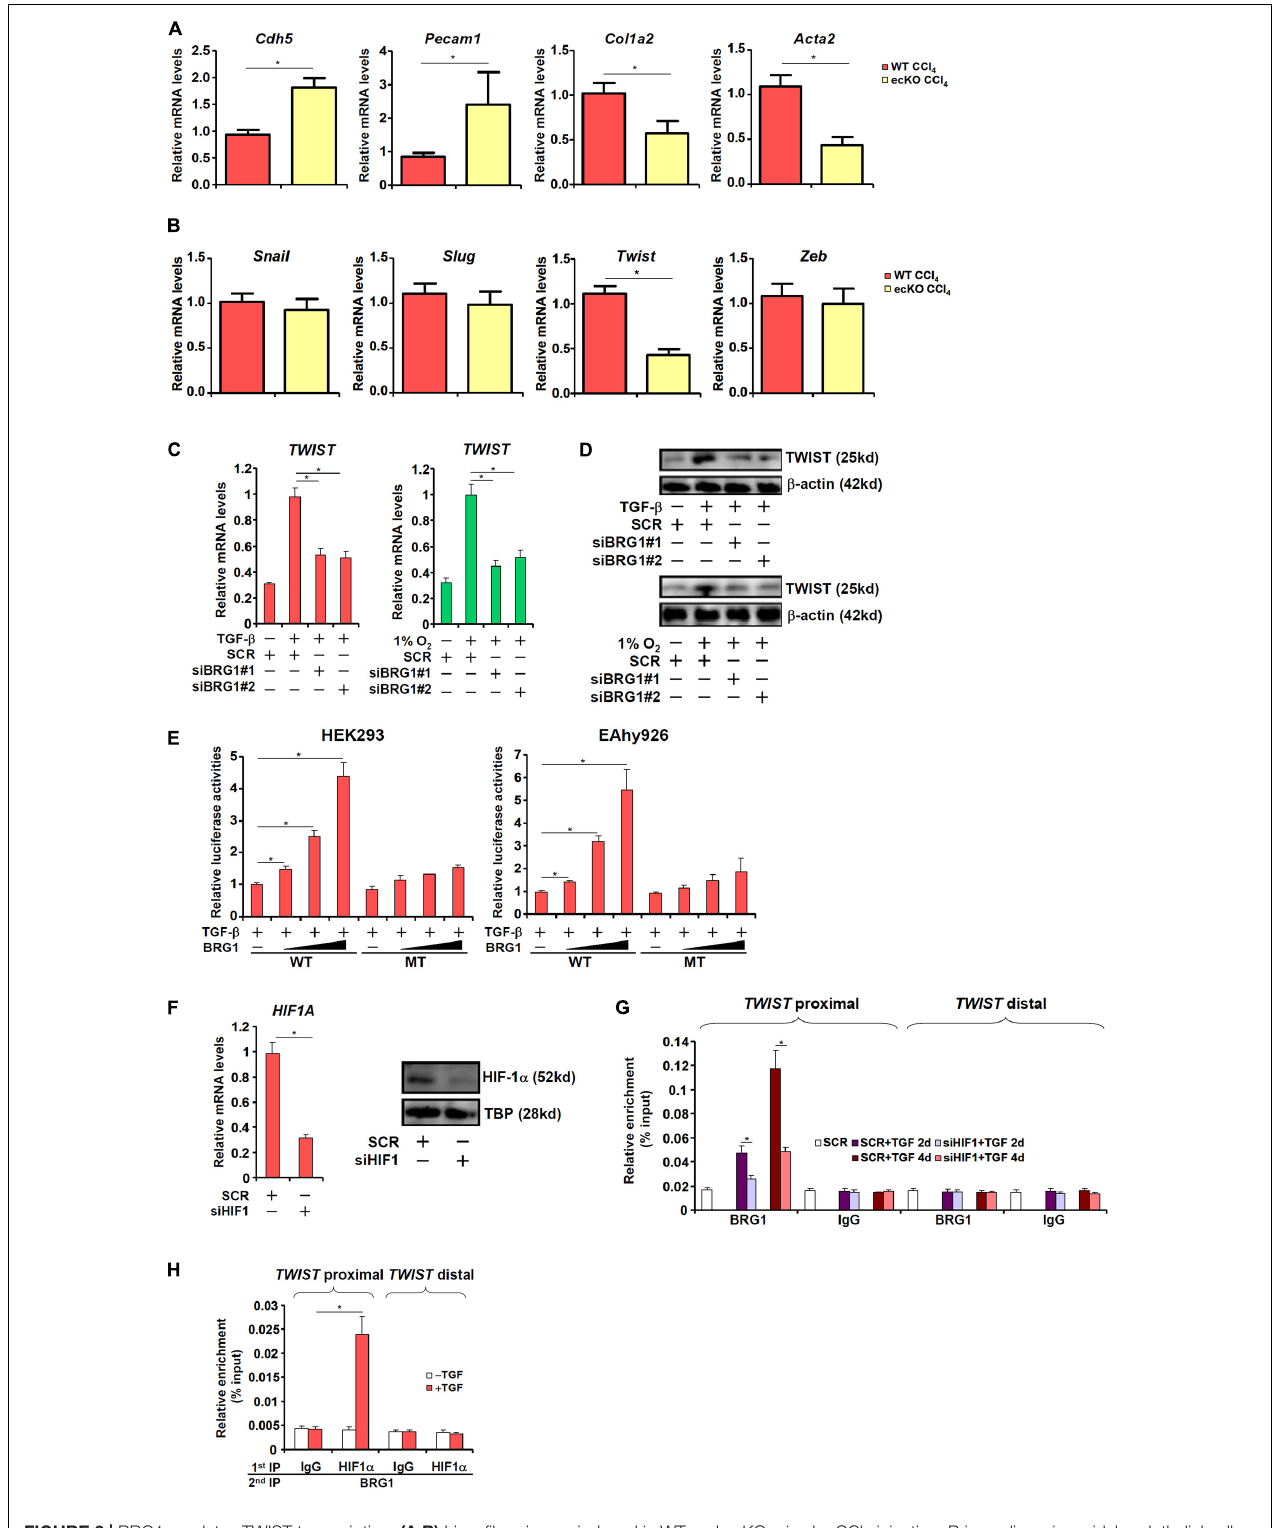
FIGURE 3 | BRG1 regulates TWIST transcription. (A,B) Liver fibrosis was induced in WT and ecKO mice by CCl 4 injection. Primary liver sinusoidal endothelial cells were isolated and gene expression levels were examined by qPCR. N = 6 mice for each group. (C,D) Human primary vascular endothelial cells were transfected with siRNA targeting BRG1 or SCR followed by treatment with TGF- β or hypoxia. TWIST expression was examined by qPCR and Western. (E) Wild type and HIF-1 α